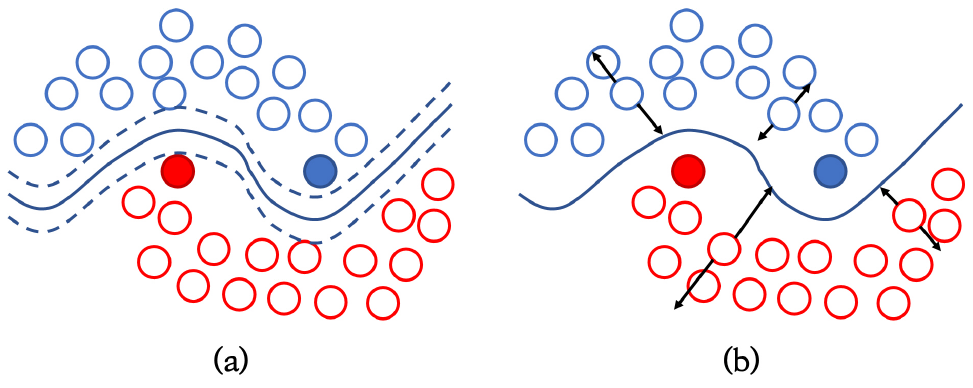
Figure 2. Illustration of the decision boundaries: ( a ) Decision boundary without the consideration of perturbation on examples; ( b ) decision boundary with consideration of perturbation on